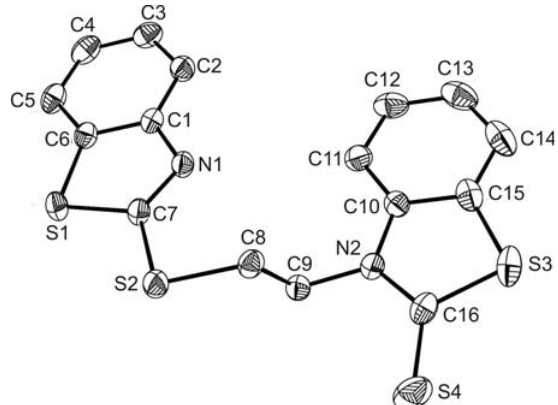
Table 1. Data collection and handling.